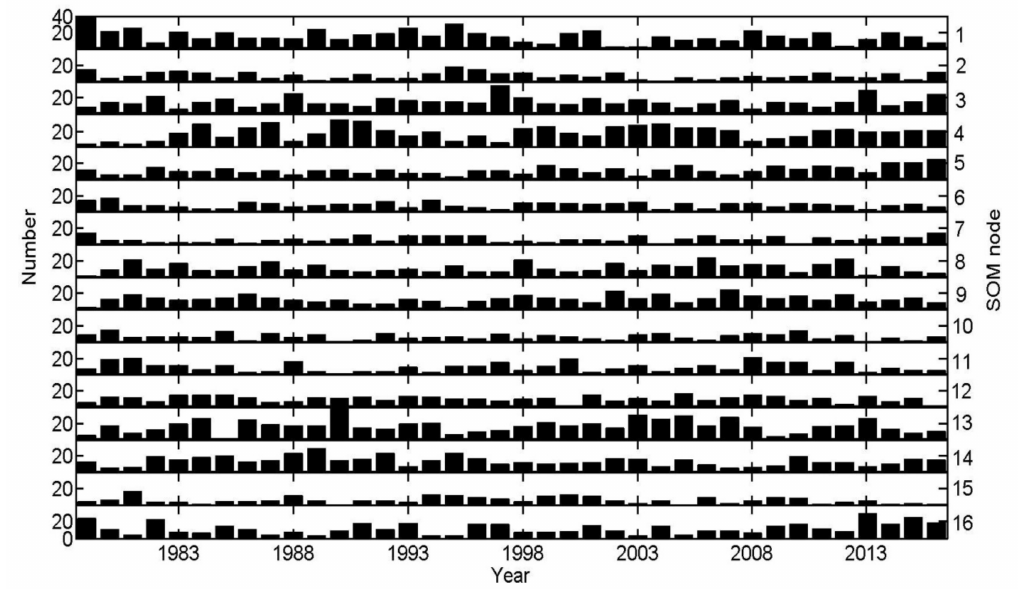
Figure 10. Time series of occurrence numbers in each season for each SOM pattern in Figure 9. The 1979 winter season includes December 1979, January 1980, and February